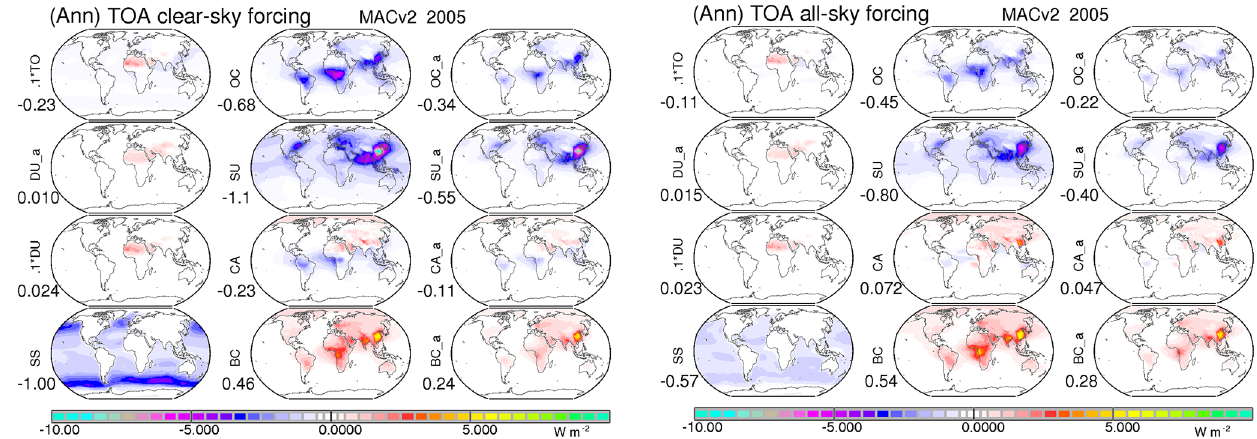
Figure 9. Annual maps for today’s direct forcing at the TOA for clear-sky (left frame) and for all-sky conditions (right frame) by total aerosol (TO, divided by 10 to fit common scale) and by coarse-mode components of anthropogenic dust (DU_a), dust (DU, divided by 10 to fit common scale) and sea salt (SS) in the left column; by fine-mode components of nonabsorbing sulfate (SU), of weakly absorbing organic matter (OC), of strong absorbing soot (BC) and of the combined carbon (CA = OC + BC) component in the center column; and by the anthropogenic contributions of all fine-mode components in the right column. Global averages for the annual direct aerosol component TOA effects are presented below the